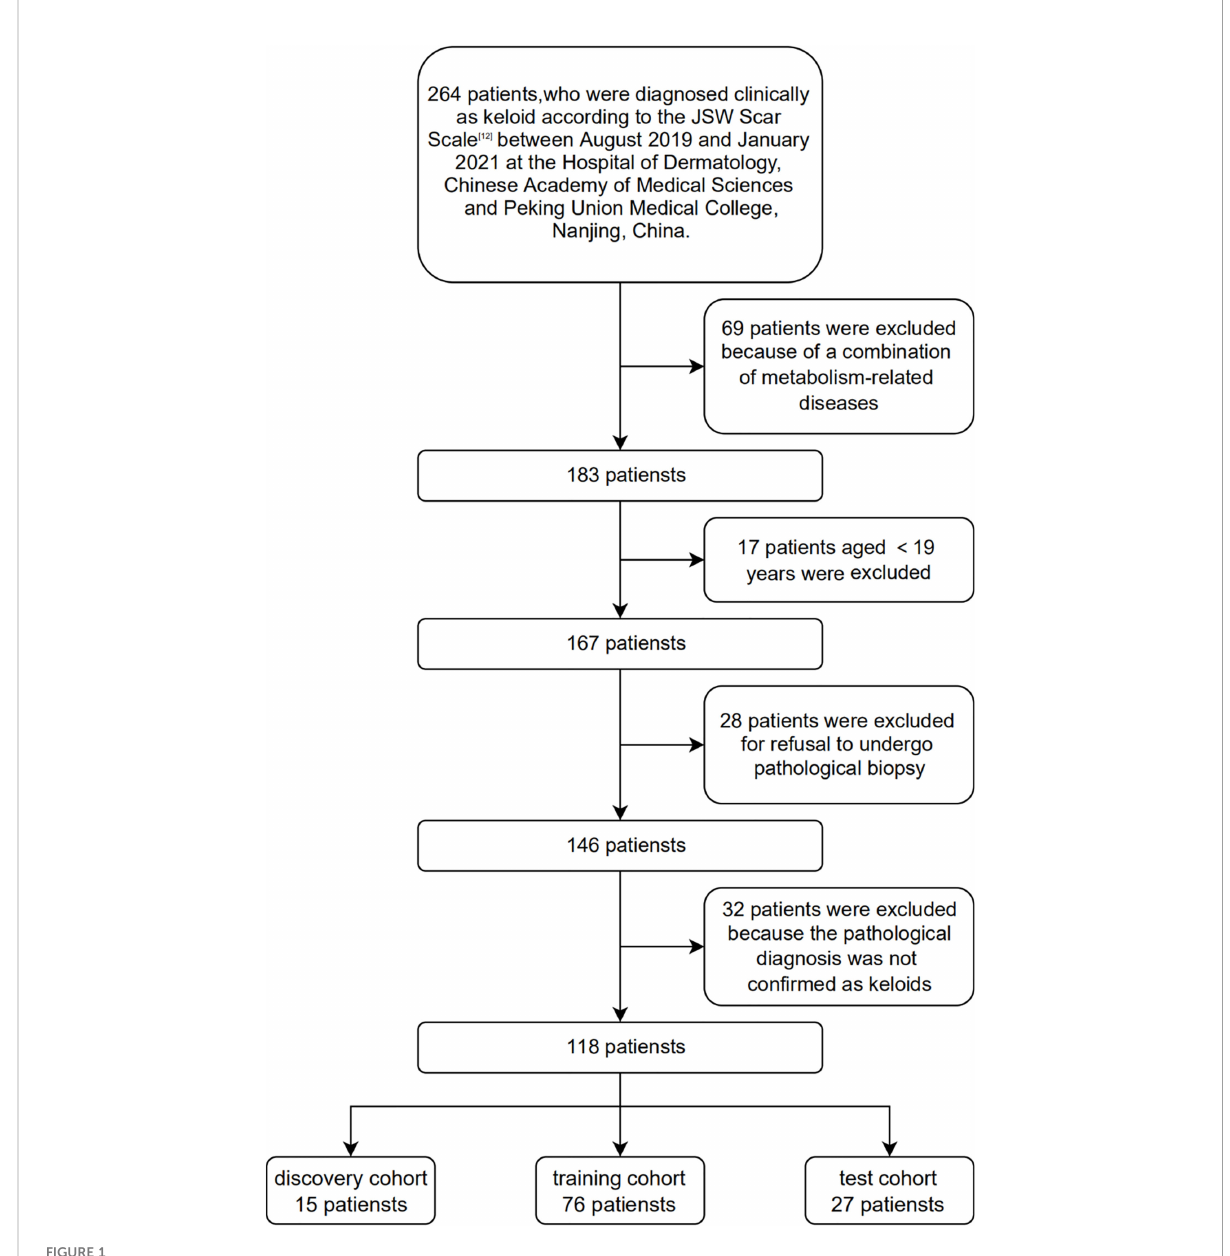
FIGURE 1 Flow chart of subject inclusion and exclusion